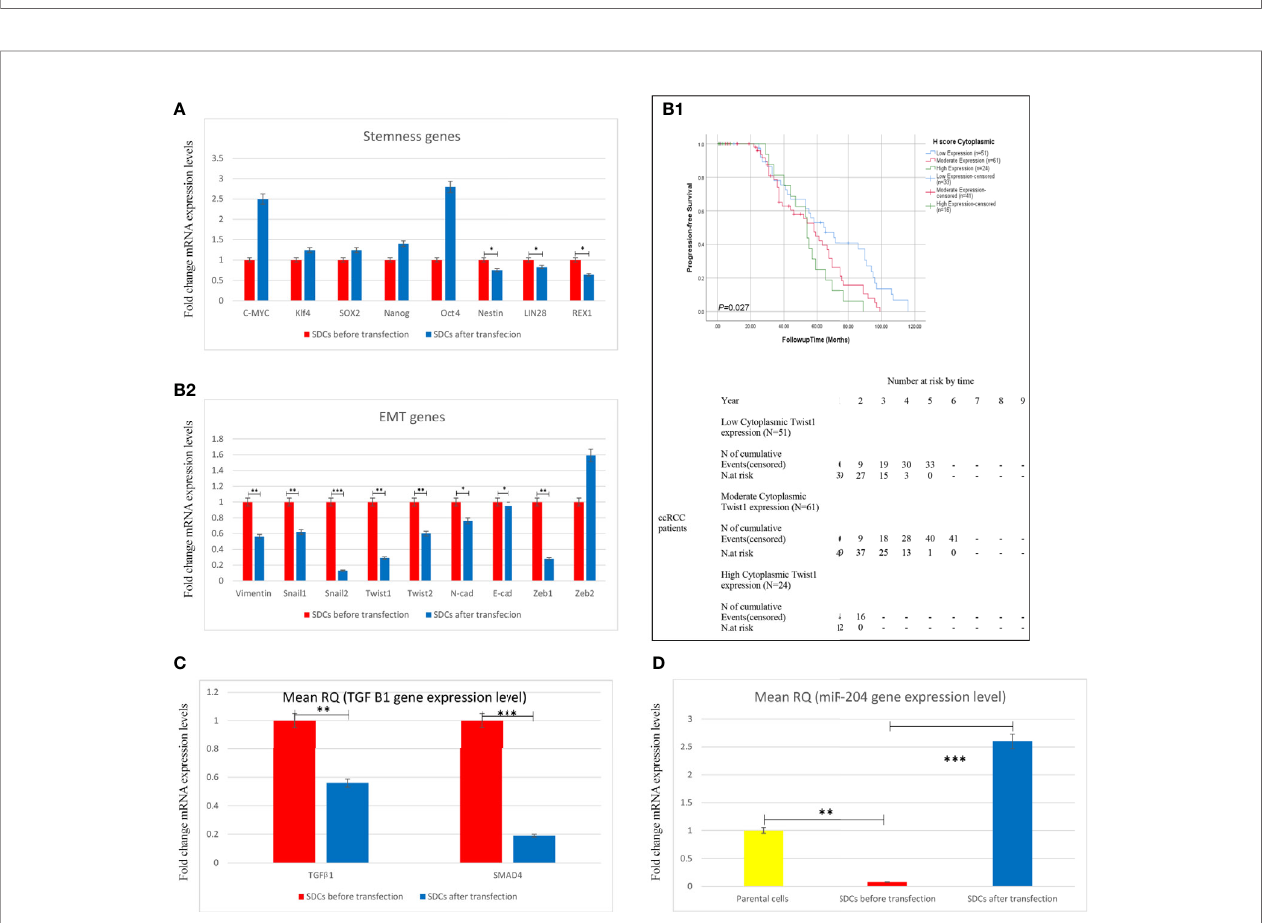
FIGURE 9 | Expression Levels of Stemness, EMT, and Angiogenesis-Related Genes, TGF- b 1 and miR204 using qRT-PCR in Spheroid-Derived Cells (SDCs) From Before and After Transfection of PCs with SiSMAD4, cytoplasmic Twist1 expression and survival rates in patients with clear cell Renal Cell Carcinoma. (A) Stem cell markers, (B2) Mesenchymal markers, (C) TGF- b 1 gene and (D) (miR204) expression of SDCs in SFDM and SDCs before and after Transfection by SMAD4 inhibition were quanti fi ed by qRT-PCR. Data are represented as mean ± SD (n = 3 each). * P < 0.05, ** P < 0.01 and *** P < 0.0001. (B1) Correlation between cytoplasmic Twist1 expression and survival rates in patients with clear cell Renal Cell Carcinoma (ccRCC). Progression-free survival (PFS) with cytoplasmic Twist1 expression grouped into low- versus moderate- versus high expression levels.